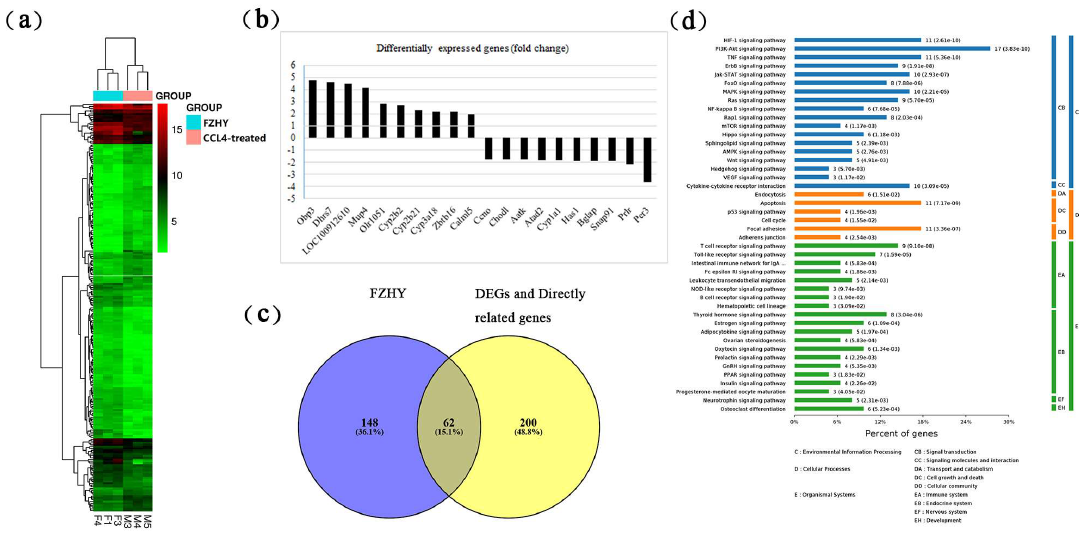
Figure 1. DEGs and potential target analysis. ( a ) Heatmap of DEGs. ( b ) Topmost regulated DEGs. ( c ) 62 potential targets from Venn analysis. ( d ) The main pathways of potential targets. FZHY, FZHY formula. M, model rats (CCl 4 -treated); F, FZHY rats (CCl 4 and FZHY-treated). Percentages in the Venn diagram: related genes/total genes. The numbers at the end of the bars represent for the p -value of pathways enrichment